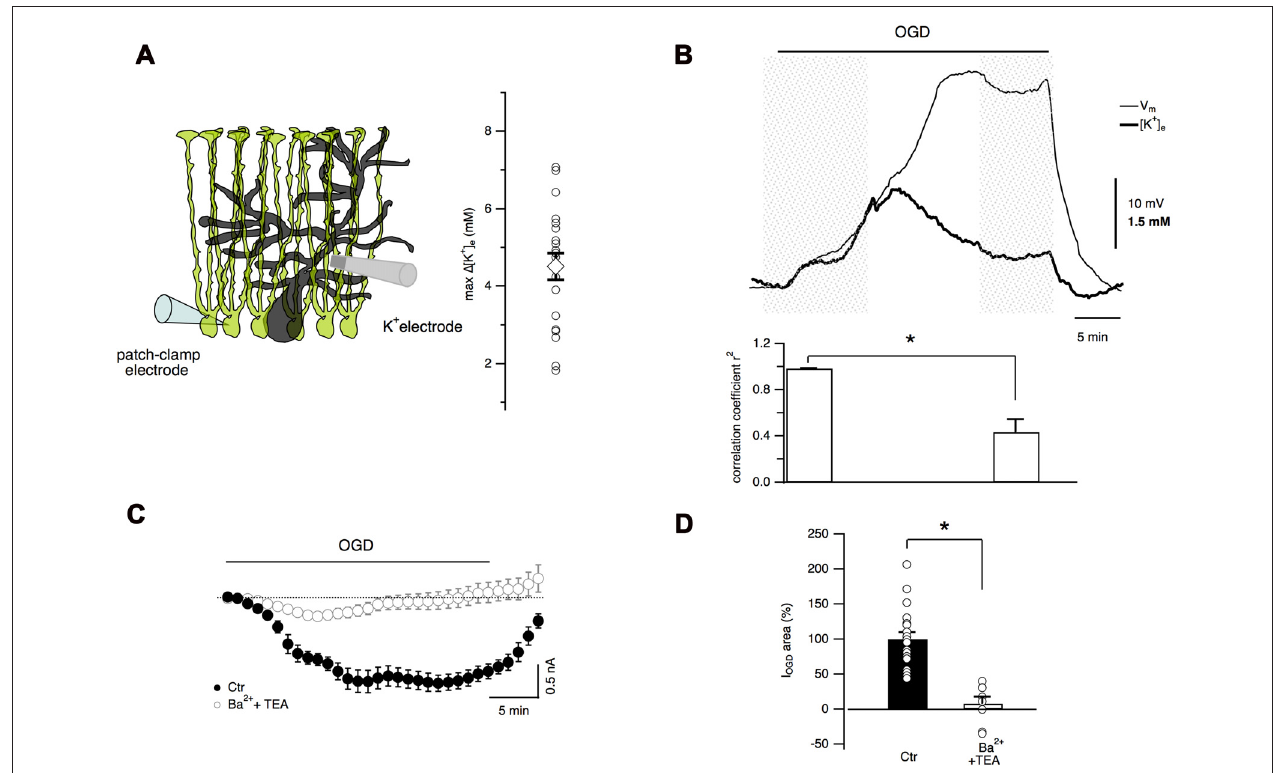
FIGURE 6 | Extracellular K + accumulation during OGD partially account for Bergmann cell depolarization. (A) Extracellular K + concentration is measured through an ion-sensitive microelectrode placed in the molecular layer. Maximal values of [K + ] e variations recorded during OGD are reported in the plot ( n = 22). (B) An example of simultaneous recordings of [K + ] e changes and Bergmann glia membrane potential during OGD (top). Bottom: during the first 10 min of OGD protocol, the membrane potential and [K + ] e increase concomitantly revealing high degree of correlation ( n = 7) while after this time, [K + ] e decreases and membrane depolarization increases further. The P value for the histogram data analysis is ∗ P = 0.02, Wilcoxon Signed-rank test. (C) Mean currents recorded in control ( n = 19) and in the presence of 5 mM Ba 2 + and 10 mM TEA ( n = 8). (D) These K + channel inhibitors significantly reduce the electrical charge of Bergmann glia I OGD ( ∗ P =